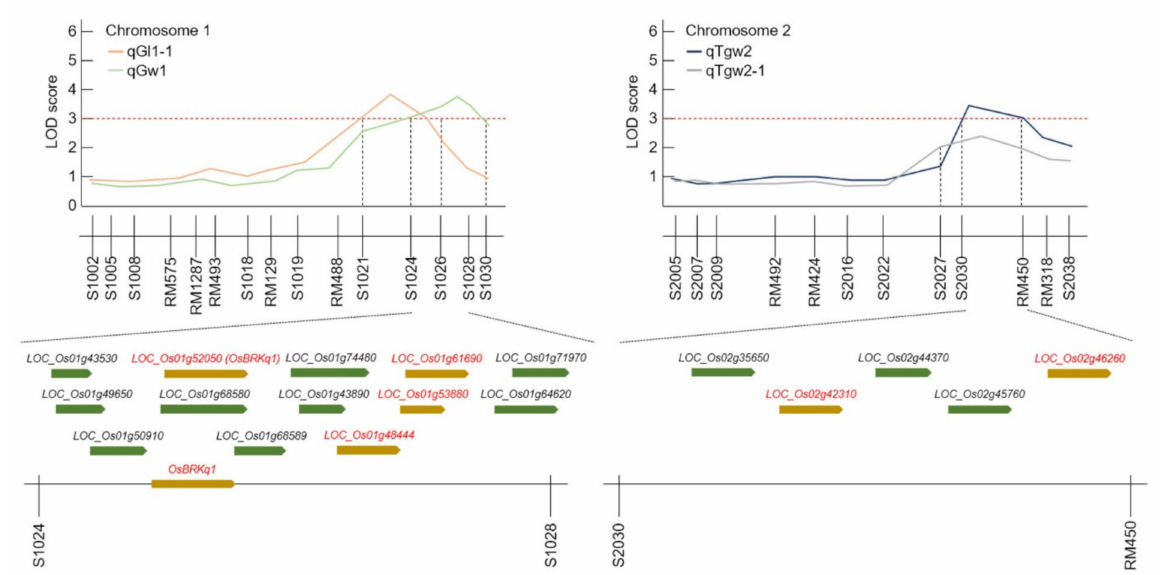
Figure 5. Quantitative trait locus (QTL) analysis and physical mapping related to grain-size candidate genes. After 2 years of QTL mapping, s1024–s1028 on chromosome 1 and s2030–RM450 on chromosome 2 were mapped consecutively. There were various candidate genes in this region, of which OsBRKq1 on chromosome 1 was screened as a grain-size-associated